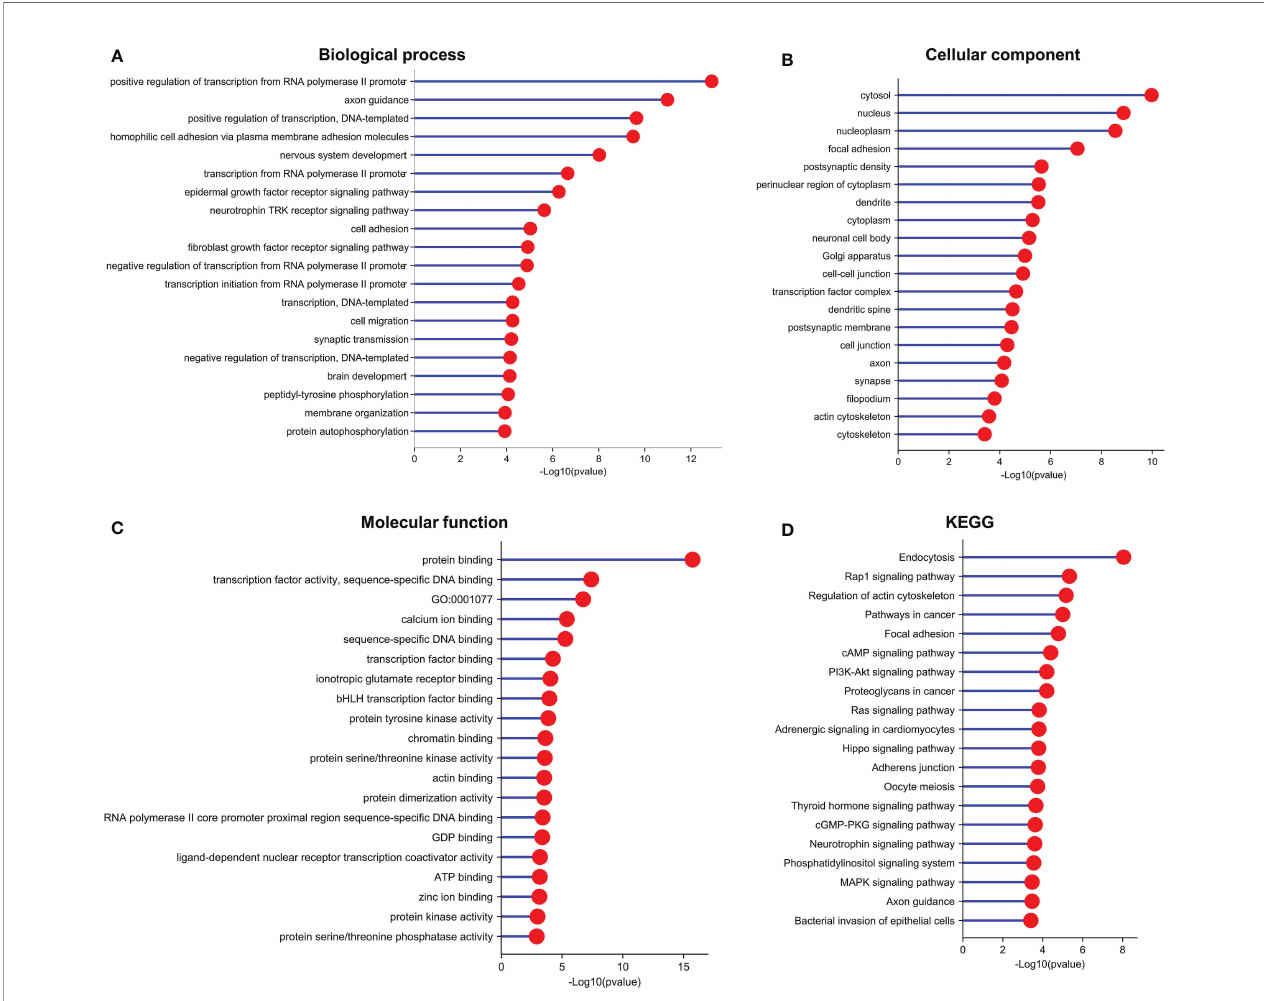
FIGURE 6 | Functional enrichment analysis indicated that the target genes of the differentially expressed miRNAs are involved in multiple pathways and biological processes. (A) GO (Gene Ontology)-BP (Biological Process), (B) GO-CC (Cell Component), (C) GO-MF (Molecular Function), and (D) Kyoto Encyclopedia of Genes and Genomes (KEGG) enrichment analysis of target genes of the differentially expressed